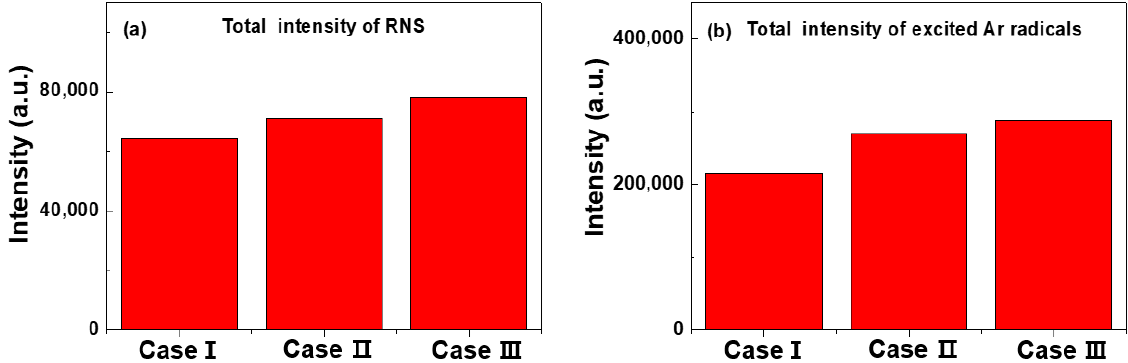
Figure 5. Total peak intensity of ( a ) excited RNS and ( b ) argon radicals from OES spectra under optimal conditions with respect to three electrode configurations of cases I, II, and III.